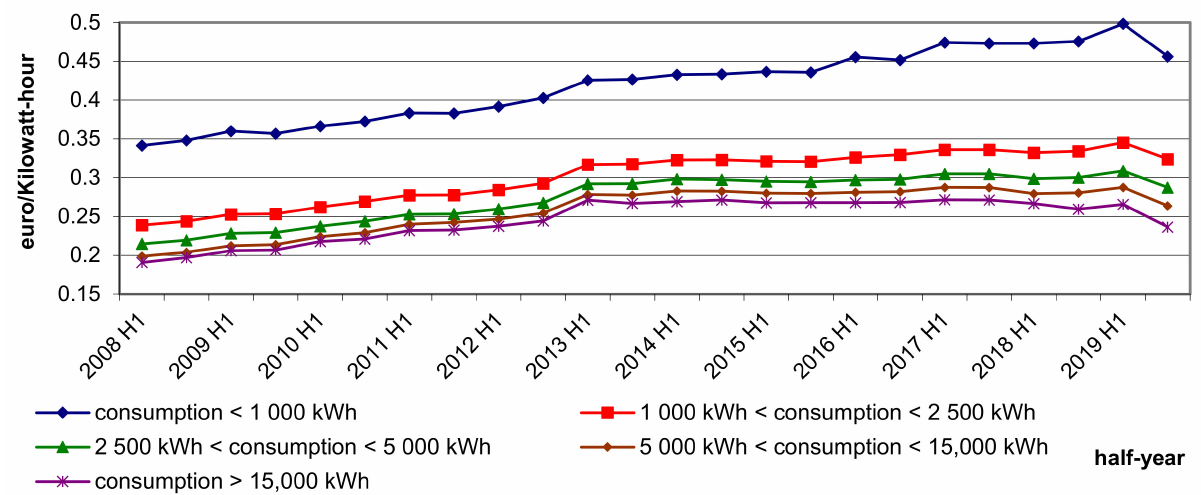
Figure 4. Electricity prices for private customers in Germany in